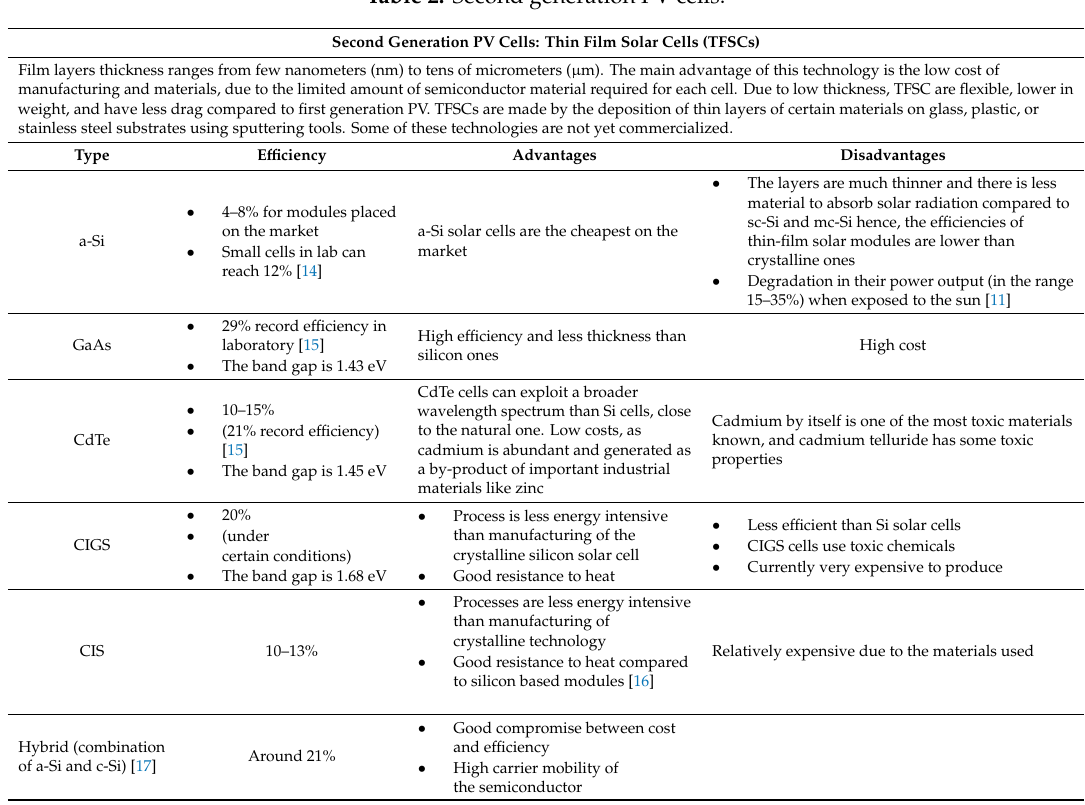
Table 2. Second generation PV cells.